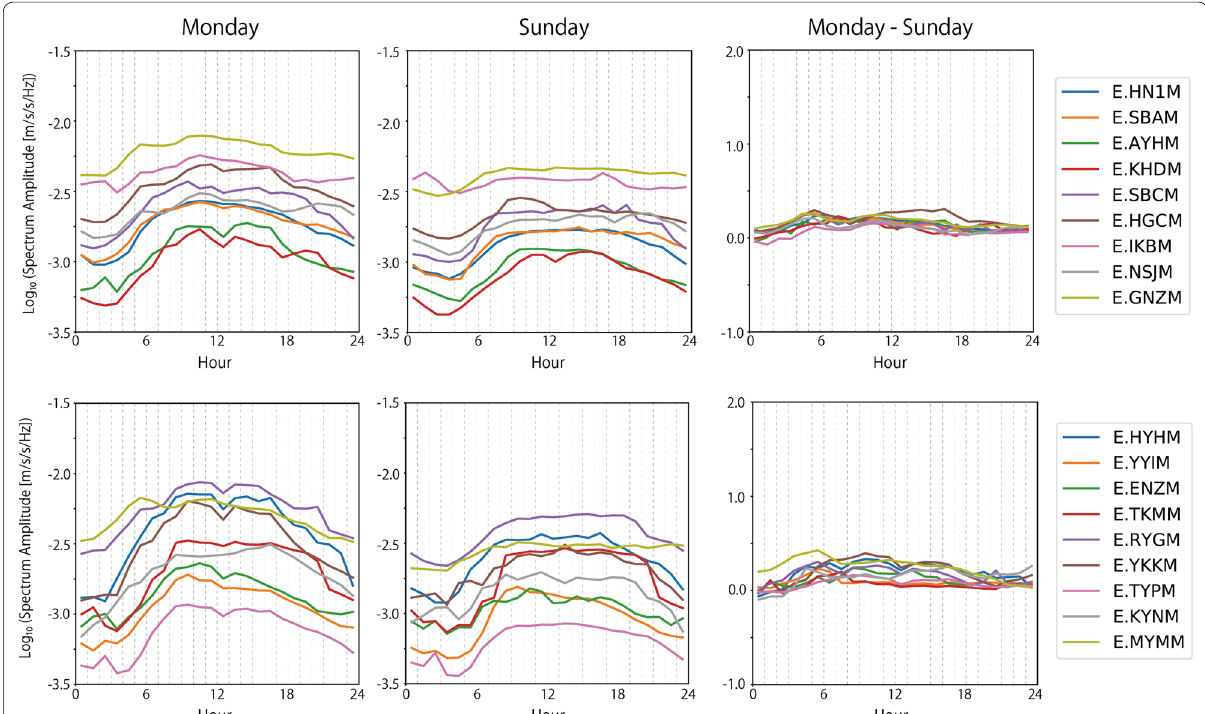
Fig. 6 Noise level at 13 Hz on Monday and Sunday. (Left) on Monday. (Middle) on Sunday. (Right) difference between the noise levels on Monday and